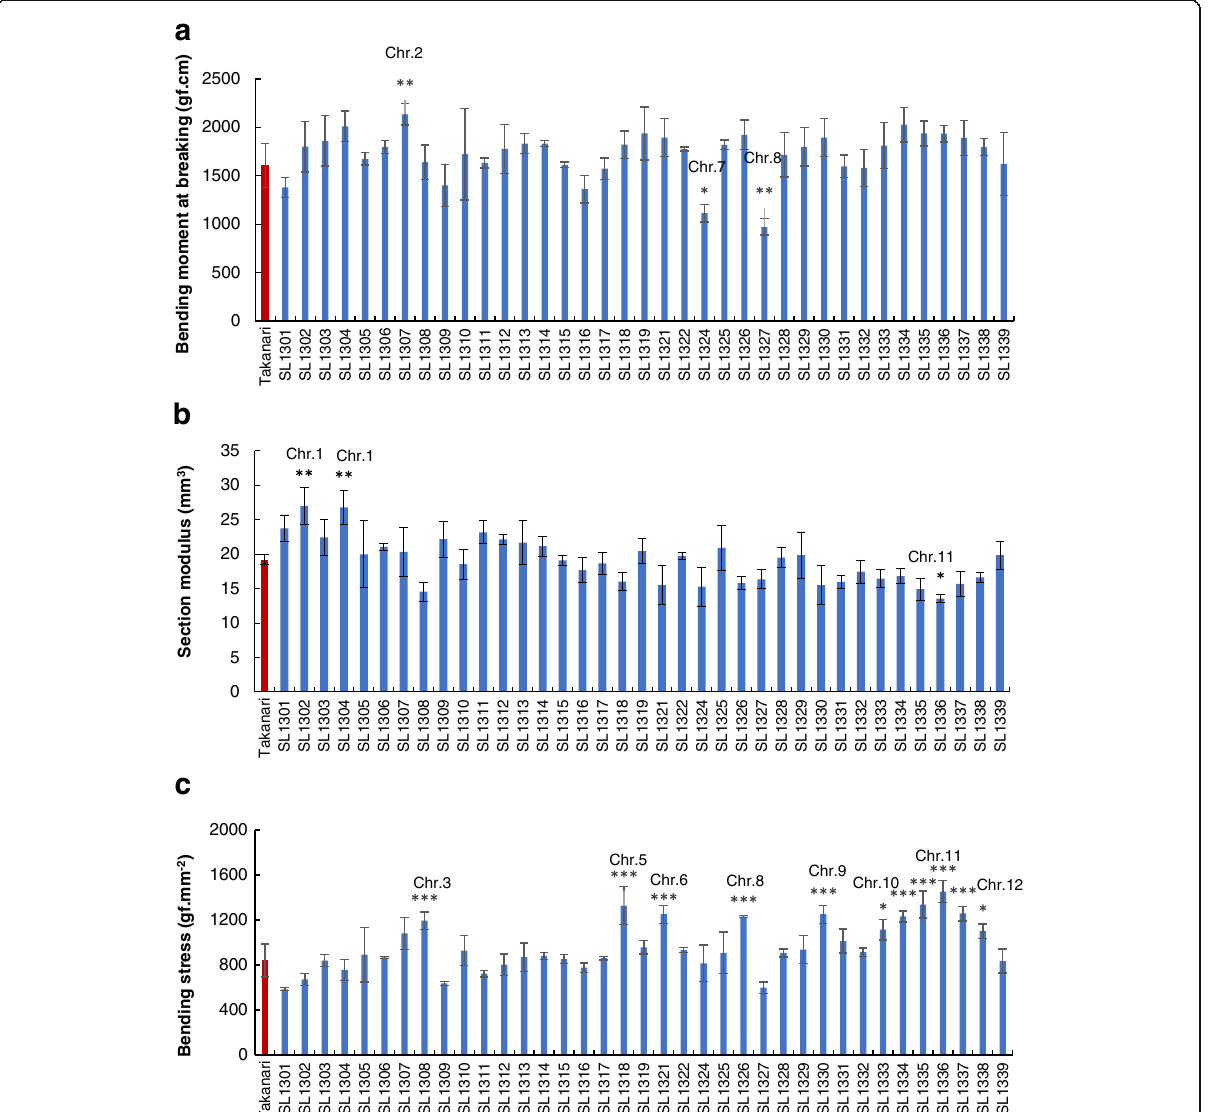
Fig. 1 Physical parameters associated with breaking-type lodging resistance in T-CSSLs in 2015. a bending moment at breaking, b section modulus, and c bending stress of the fourth internode. Data are expressed as the mean±SD. *, **, and *** represent significant differences at 5, 1, and 0.1% level,